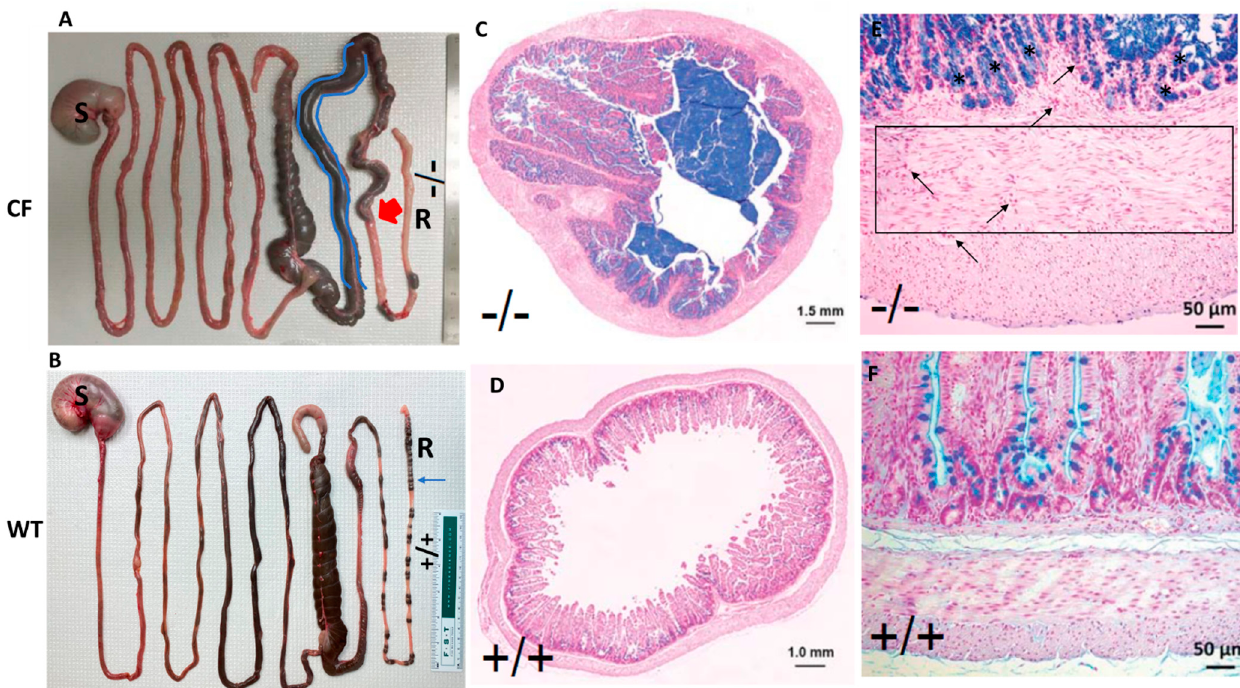
Figure 2. Intestinal obstruction is a common phenotype in CF rabbits. ( A ) Gross images of the GI tracks of a CF rabbit. The proximal colon (highlighted in blue) was dilated. Red arrow indicates the point of blockage. ( B ) Gross images of the GI tracks of a WT rabbit. Blue arrow indicates feces pellets, which are missing in the CF rabbit. ( C ) AB-PAS staining of the cross section of a CF rabbit colon. ( D ) AB-PAS staining of the cross section of a WT rabbit colon. ( E ) AB-PAS staining of the longitudinal sections of a CF rabbit colon. Region within the box is a representative area of interstitial fibrosis. Arrows indicate inflammatory infiltration; asterisks indicate goblet cell hyperplasia. ( F ) AB-PAS staining of the longitudinal sections of a WT rabbit colon. S: stomach. R: rectum. -/-: CFTR-/-. +/+: CFTR+/+.